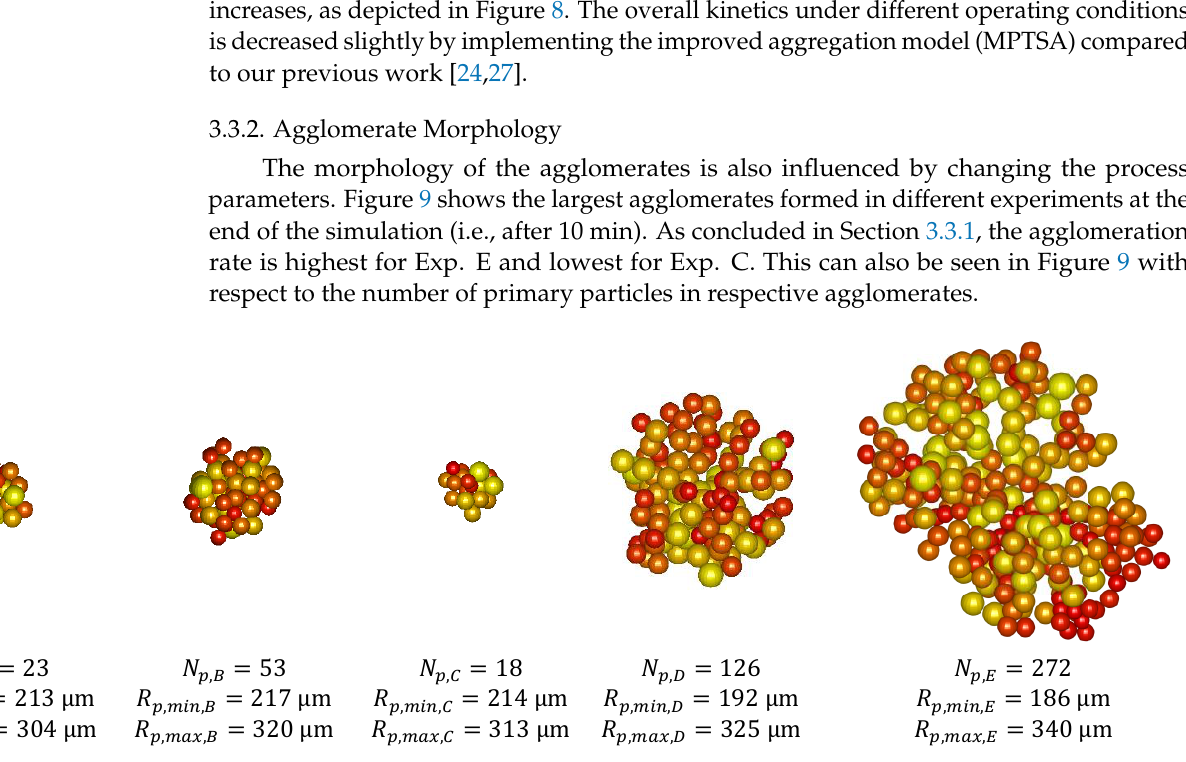
Figure 9. Largest agglomerate (with the number of primary particles; red denoting the smallest, 𝑅 𝑝,𝑚𝑖𝑛 and yellow the largest primary particle, 𝑅 𝑝,𝑚𝑎𝑥 ) formed after 10 min of CVMC simulations for different experiments.